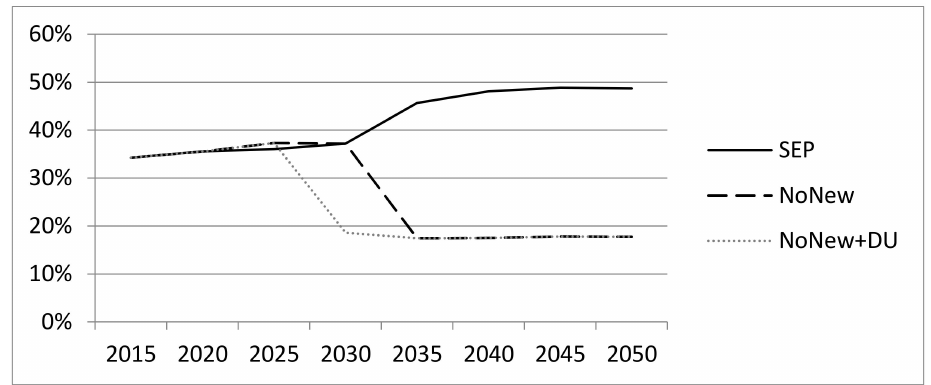
Figure 2. Three assumptions on development pathways for nuclear energy, share of electricity